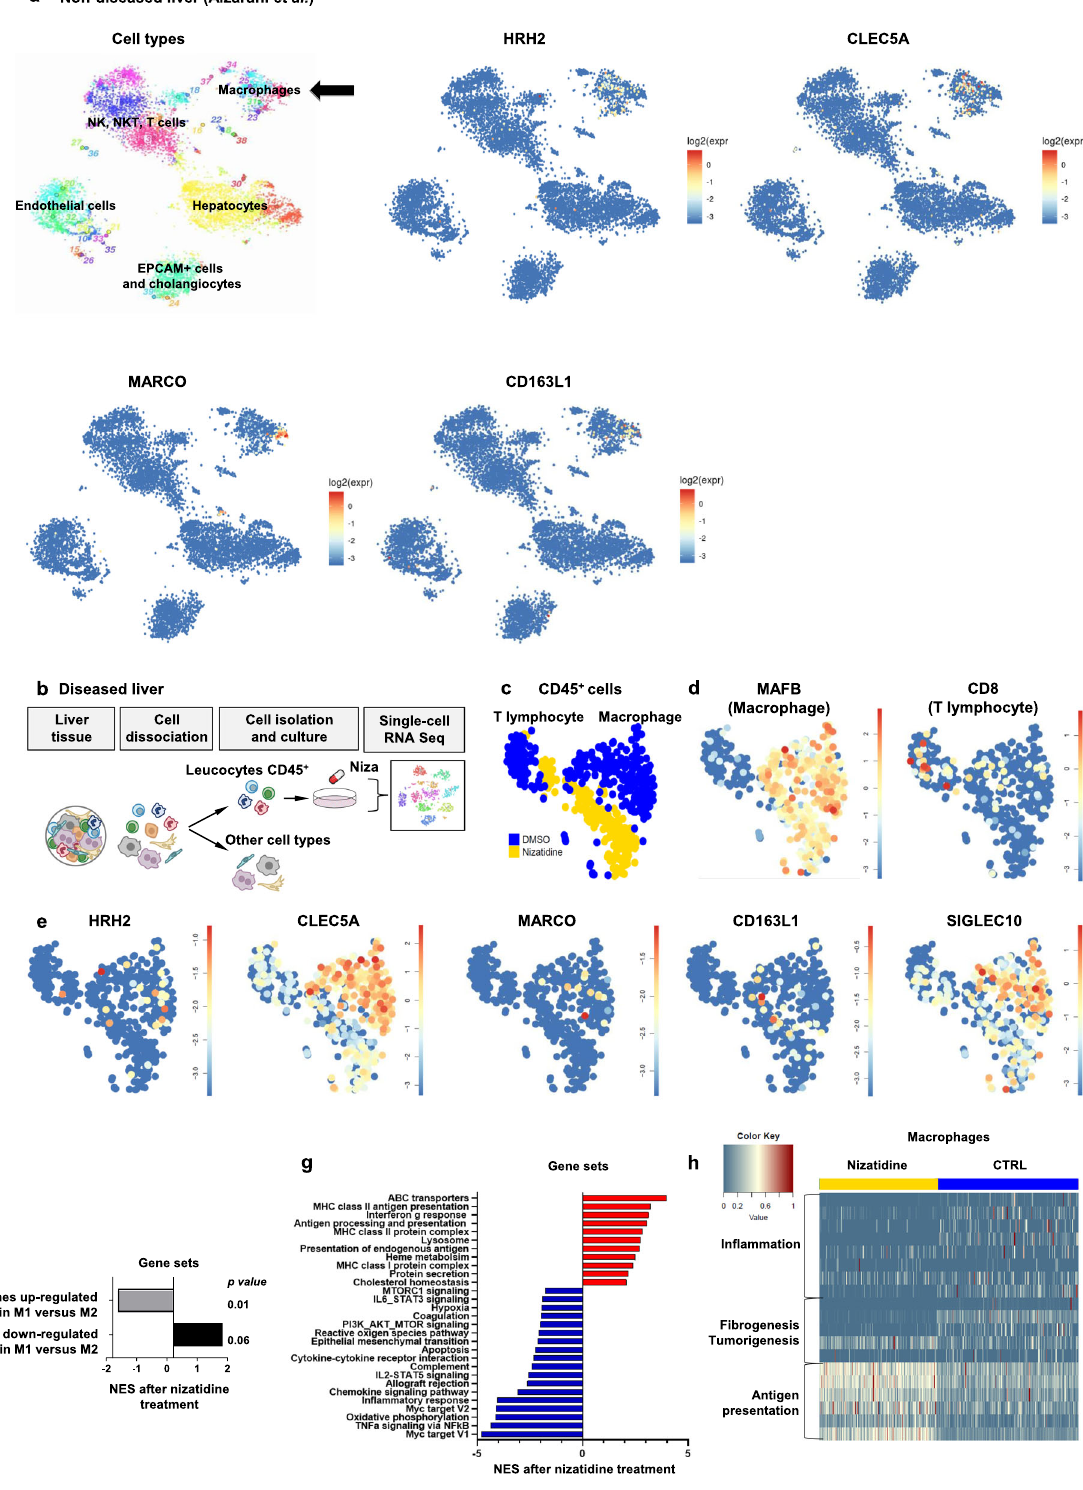
Nizatidine reverts the PLS poor-prognosis status and decreases HCC cell viability in ex vivo patient-derived models . Finally, we aimed to investigate the potential clinical ef fi cacy of nizatidine in advanced liver disease. First, we performed an organotypic ex vivo culture of diseased, non-tumoral human liver tissues, preserving multicell-type tissue architecture, including liver